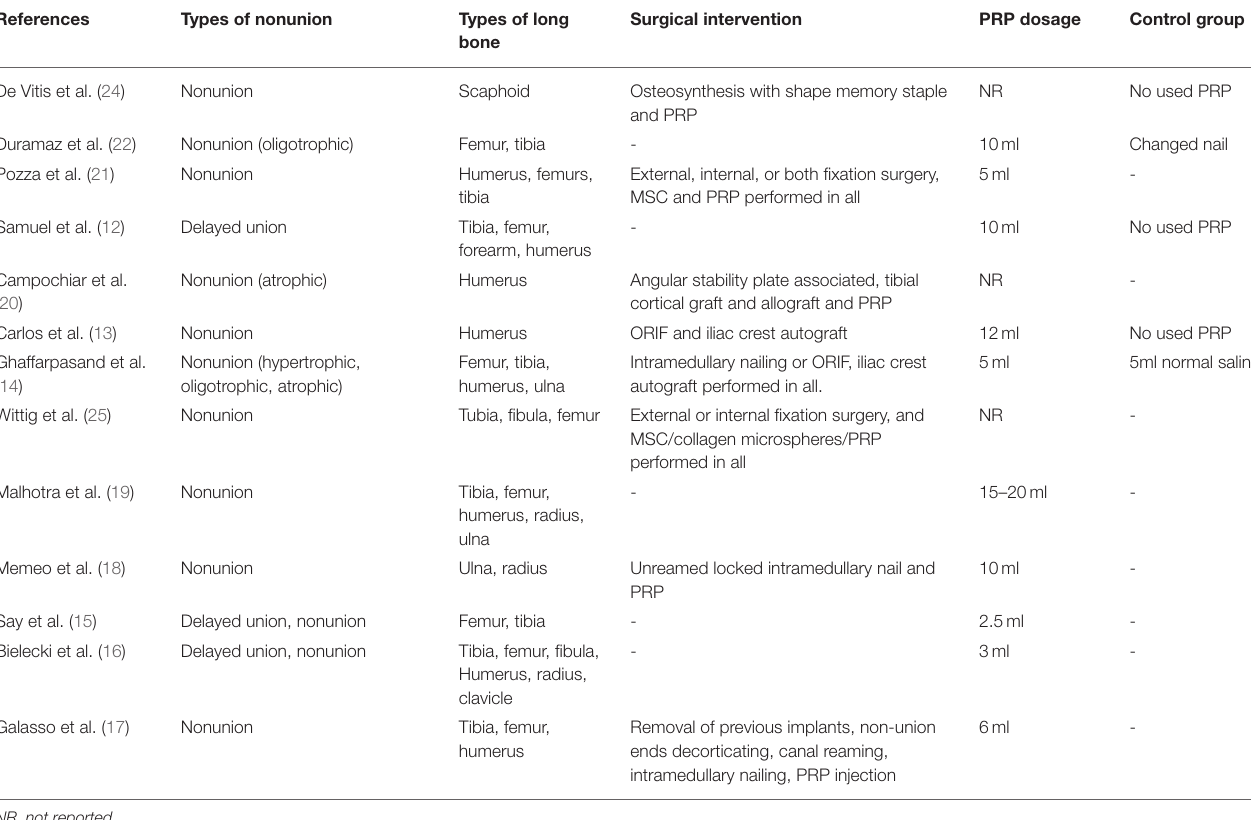
TABLE 2 | The intervention measures in patients with delayed union or nonunion of all enrolled studied.